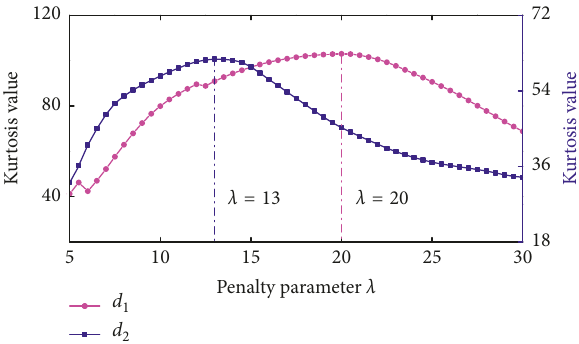
Figure 36: Envelope spectra kurtoses for different penalty values.